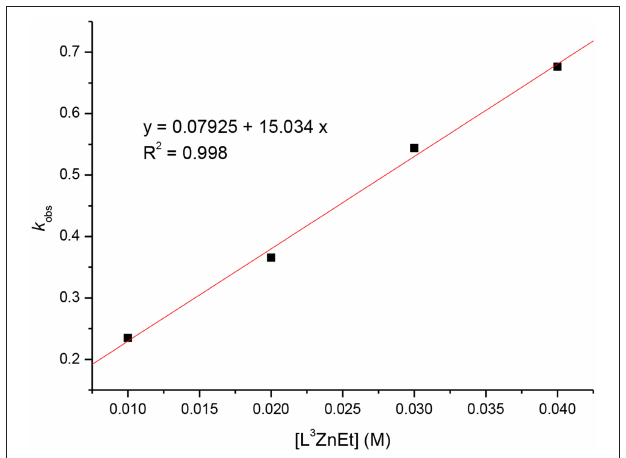
is far from the zinc catalytic center. The initiator was replaced by a methanol molecule because different alcohol molecules often show similar activity (Chang et al., 2015). The mechanism is shown in Figure 10